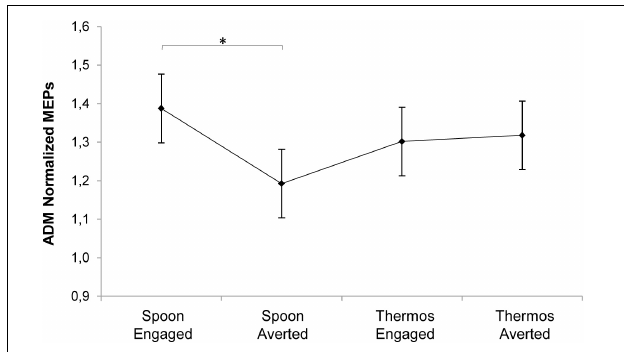
FIGURE 5 | Plot of the interaction between action and condition predictors on MEP normalized amplitude for the ADM muscle at T 1 . Asterisk indicates a statistically significant difference ( p < 0.05). Bars refer to standard